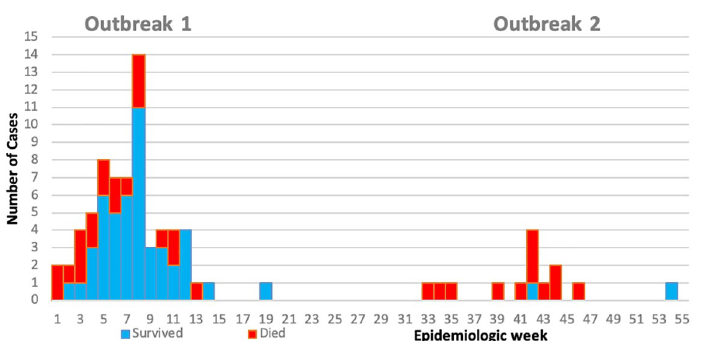
Fig 4. Mortality distribution in the two outbreaks in Ebonyi State, 2017–18 of confirmed and probable cases.